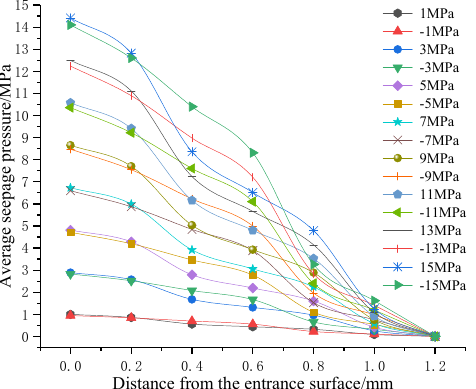
Figure 22. Pressure curves of each section under different pressure drops.